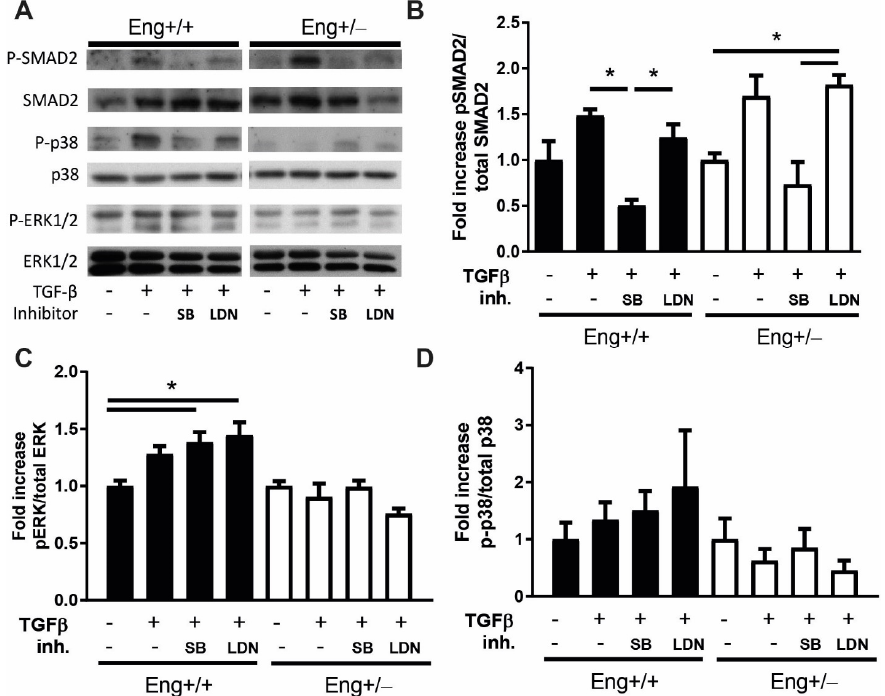
Figure 4. Eng+/ − macrophages show blunted TGF β and BMP signaling responses in vitro. ( A ) Western blot analysis of Eng+/+ and Eng+/ − cultured murine macrophages with GM-CSF, stimulated 60 min with TGF β (2.5 ng/uL), SB (10 µ M), and LDN (100 nM). Representative blots of N = 3 are shown. ( B ) Densitometric analysis of the blots shown in (A), expressed as percentage of phosphorylated Smad2 relative to total amount of Smad2. N = 3. ( C ) Quantification of the blots as shown in (A), expressed as percentage of phosphorylated ERK relative to total amount of ERK protein. N = 3. ( D ) Quantification of the blots in (A), expressed as the percentage of phosphorylated p38 relative to total amount of p38 protein, N = 3–4. Error bars are SEM. * p < 0.05. Int. J. Mol. Sci. 2021 , 22 , x FOR PEER REVIEW